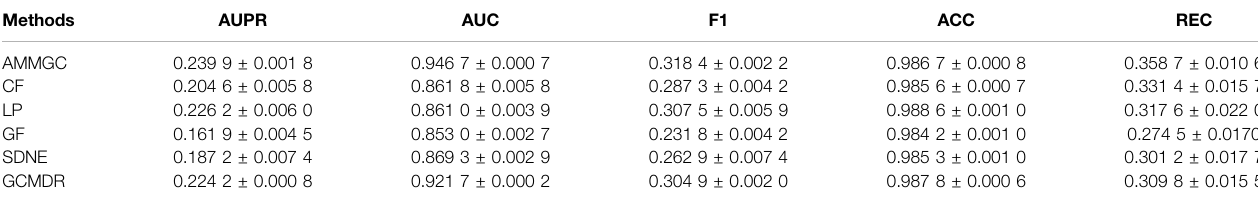
TABLE 1 | 5-CV performances of different prediction methods.